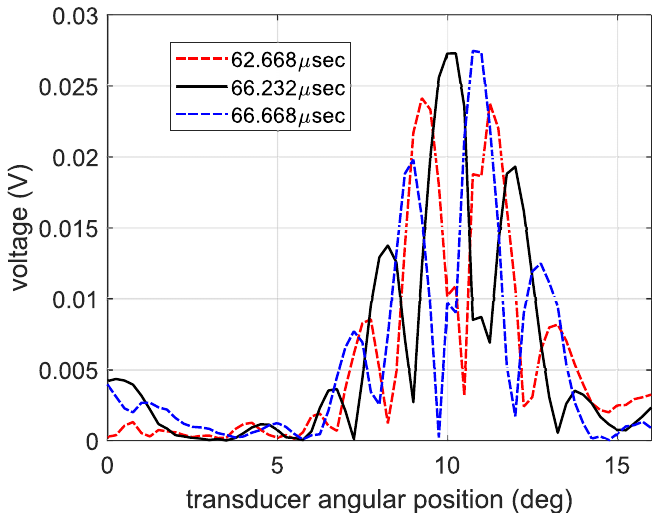
Figure 6. Three slices of the surface plot in Figure 5a taken at the beginning, middle and end of the A0 waveform.